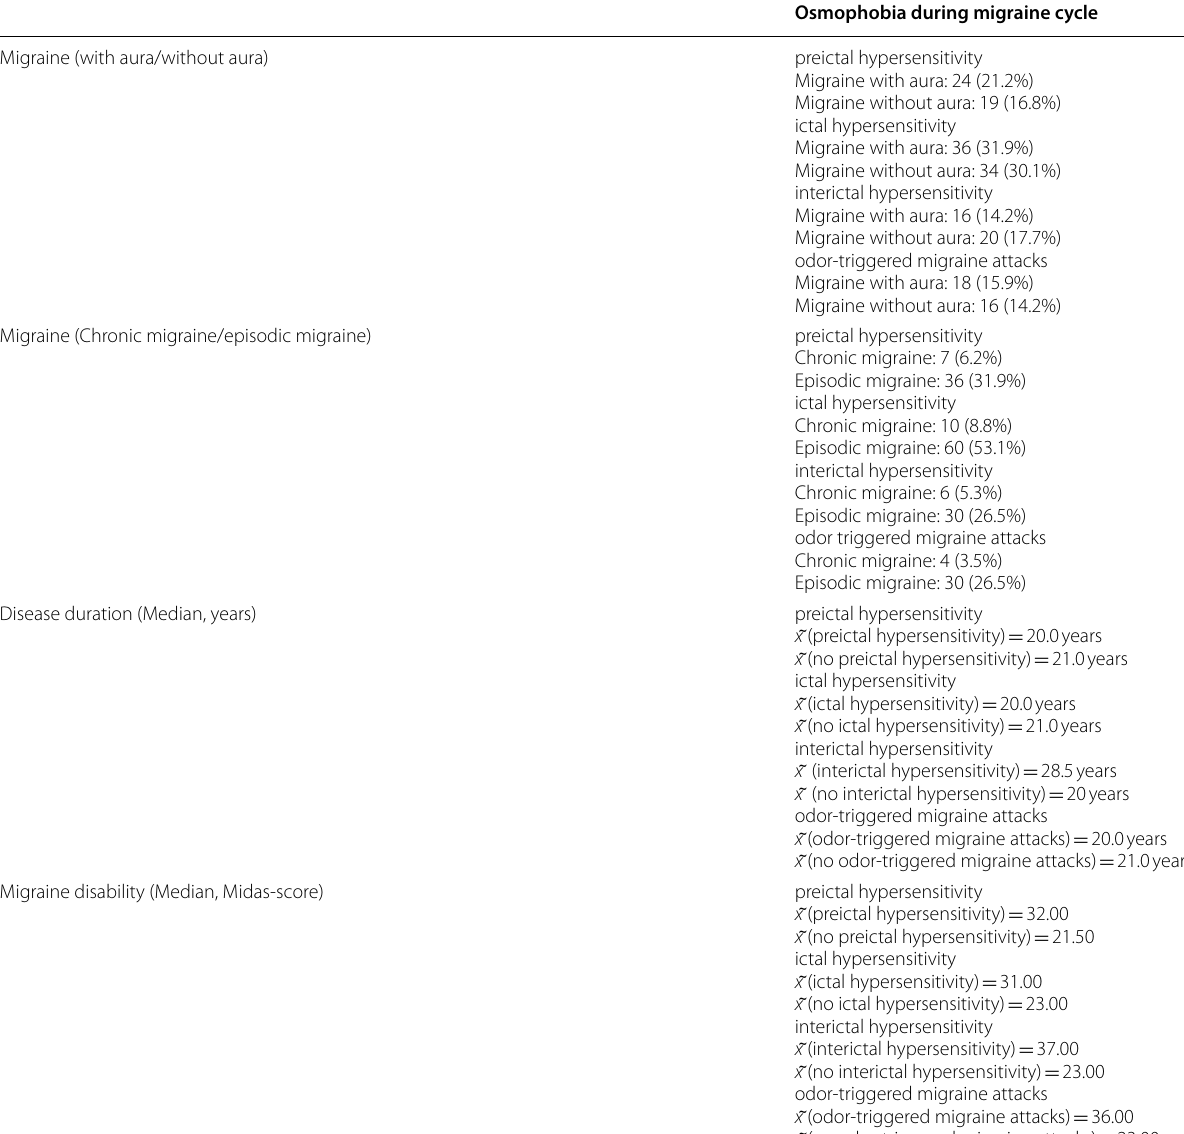
Table 4 Migraine diagnosis and olfactory sensitization in n Migraine (with aura/without aura) preictal hypersensitivity